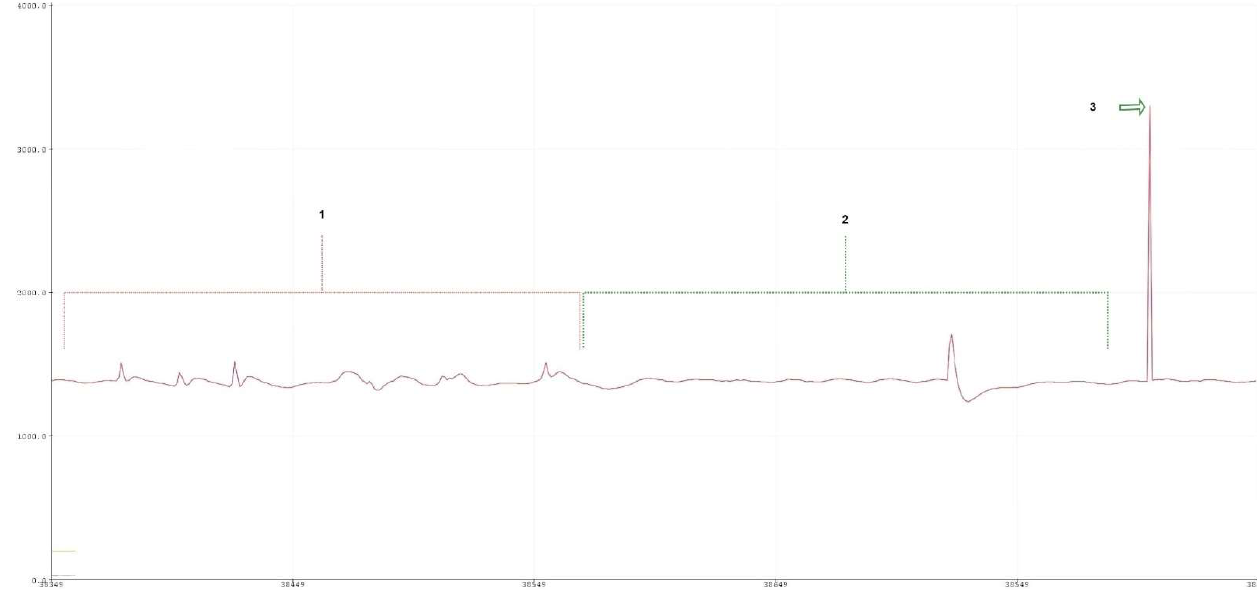
Figure 17. Forearm electromyographic signal.